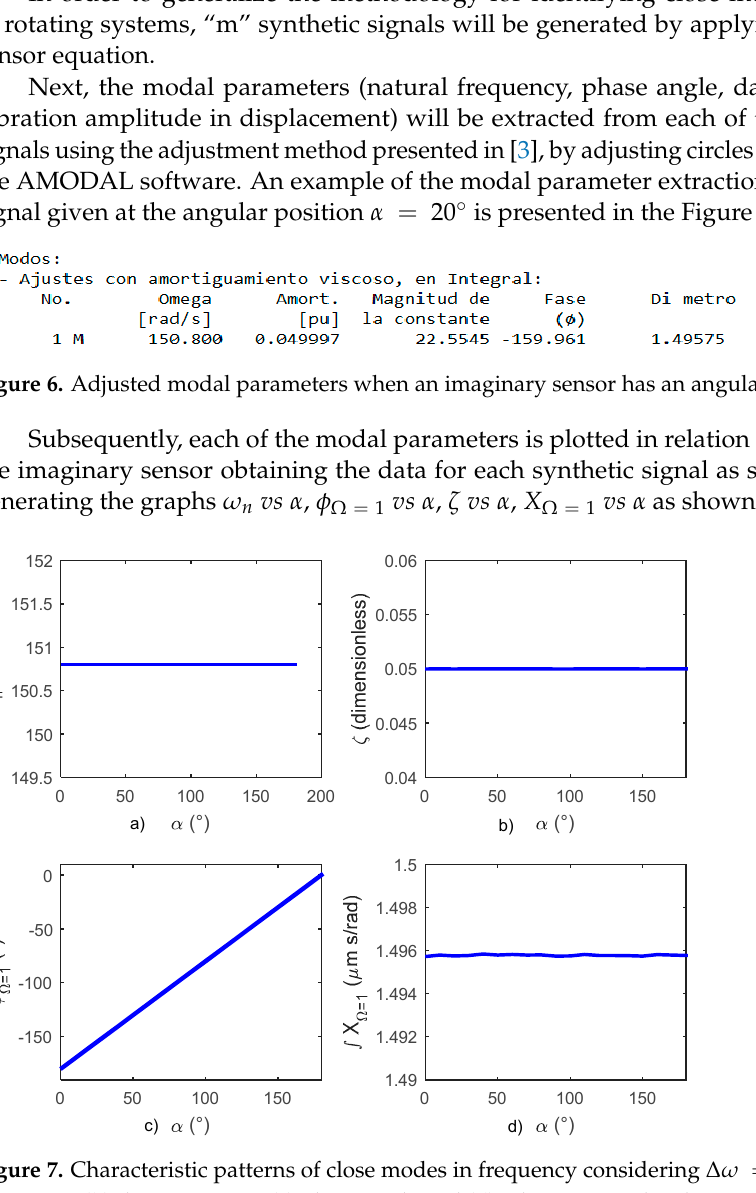
( b ) Figure 5. Polar diagram with close modes at ( a ) 45° and ( b ) 135° ( μ m ). Figure 5a and b represent the coupled mode with a red dotted line observed by a sensor at 0°, while the black dotted line is observed by a sensor at 90°, and the sensor placed at 45° and 135°, represented in blue, appears to display a single vibration mode. Figure 4 graphically represents the close mode problem in rotors. A methodology for the identification of close modes in structures was presented recently in [14]. The study pre- sented does not consider the effect of the phase angle to perform the identification. It should be noted that for both the horizontal and vertical mode of Figures 2, 4 and 5, neither does the maximum vibration amplitude in displacement at resonance occur ex- actly with a delay of 90° of the phase angle, nor is there a perfect circle for the vibration